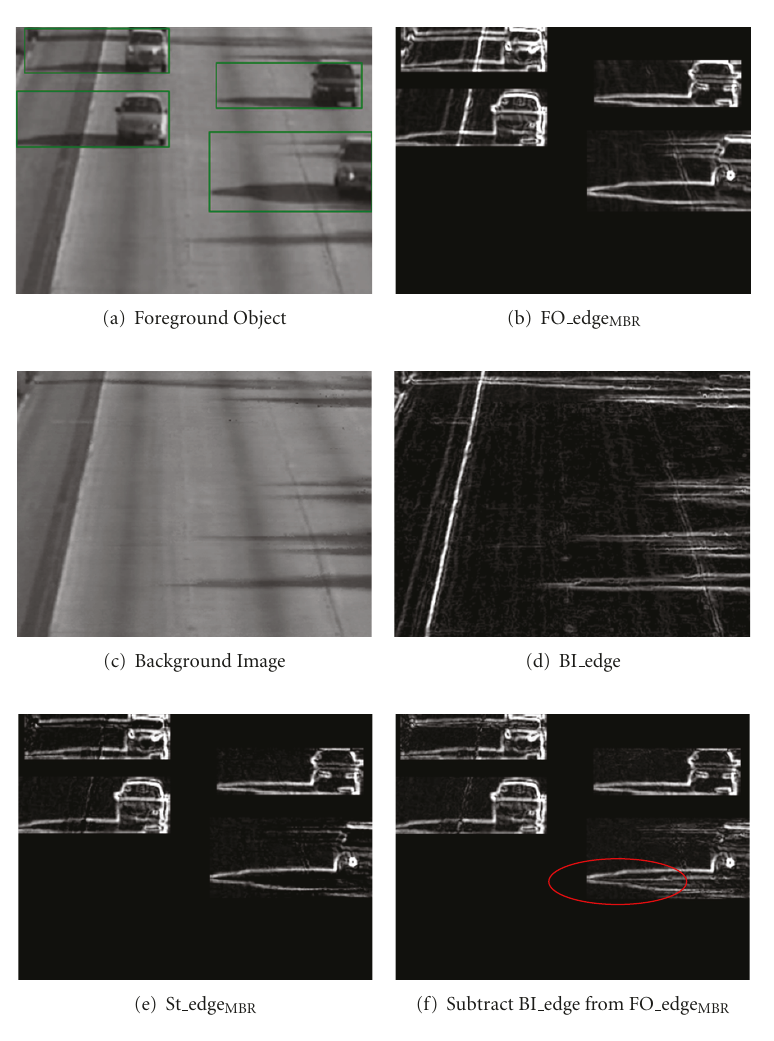
Figure 8: Examples of the ground surface with textures.